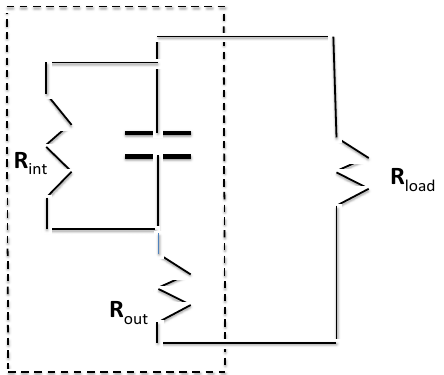
Figure 9. Assumed equivalent circuit. The area inside the dashed box represents the assumed equivalent circuit for low frequency behavior.